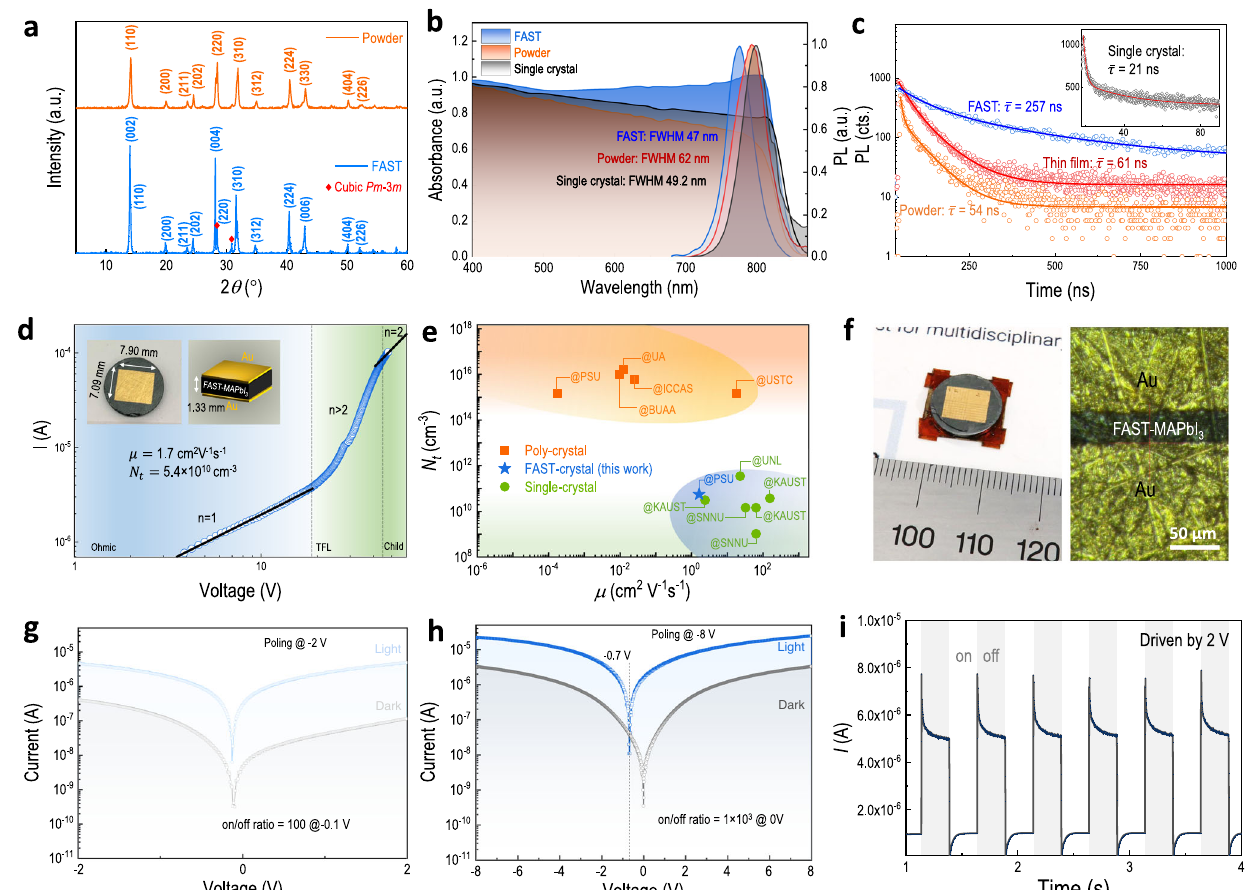
fi lm and single crystal of MAPbI 3 . The orange square, blue star, and green circle represent the poly-crystal, the FAST-crystal, and the single crystal, respectively. f Picture of the MIM transistor device and an optical microscopic image showing the channel length of 36 µ m of the transistor device. I – V curve of the FAST pho- todetector under dark and light with poling bias of g − 2V and h − 8V,respectively. i Transient photocurrent of the FAST-MAPbI 3 photodetector under a periodic on/ off light switching